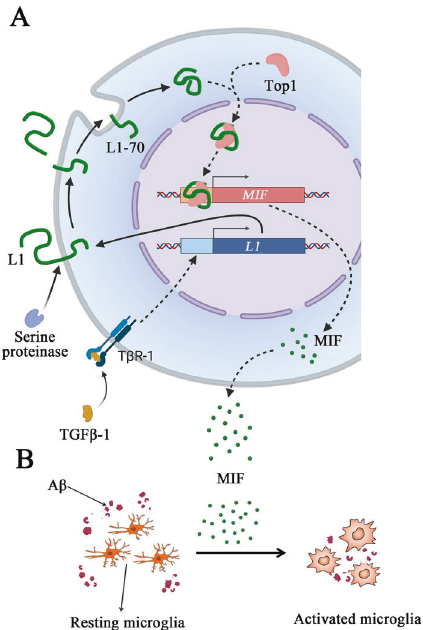
Fig. 7 Working model of L1-70 involved in the clearance of A β in the brain. A Under the action of serine-dependent proteases, the L1-70 can be cleaved from full-length L1 molecule located on the plasma membrane of neural cells, and then since the evidence for L1-70 binding to Top1 in the nucleus to form a complex which can regulate the expression of MIF gene. B MIF could then be secreted from the cells to activate microglia and promote the clearance of A β in the